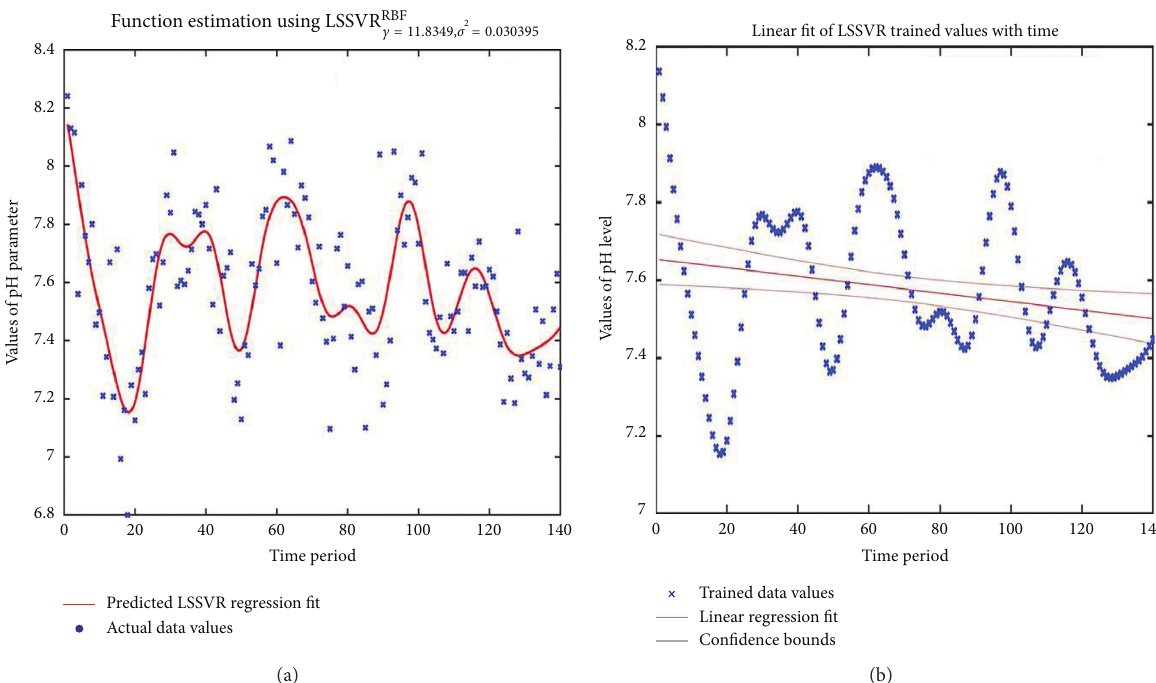
Figure 13: (a) LSSVR regression fit of pH data at Bridge. (b) Linear regression fit of LSSVR trained pH values at Bridge.